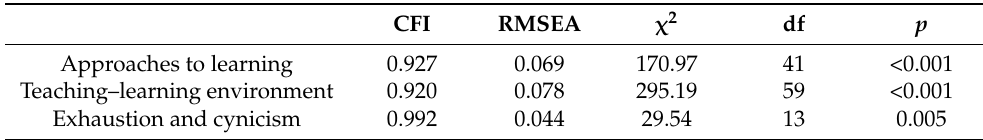
Table 1. Result of the confirmatory factors analyses. CFI RMSEA χ 2 df